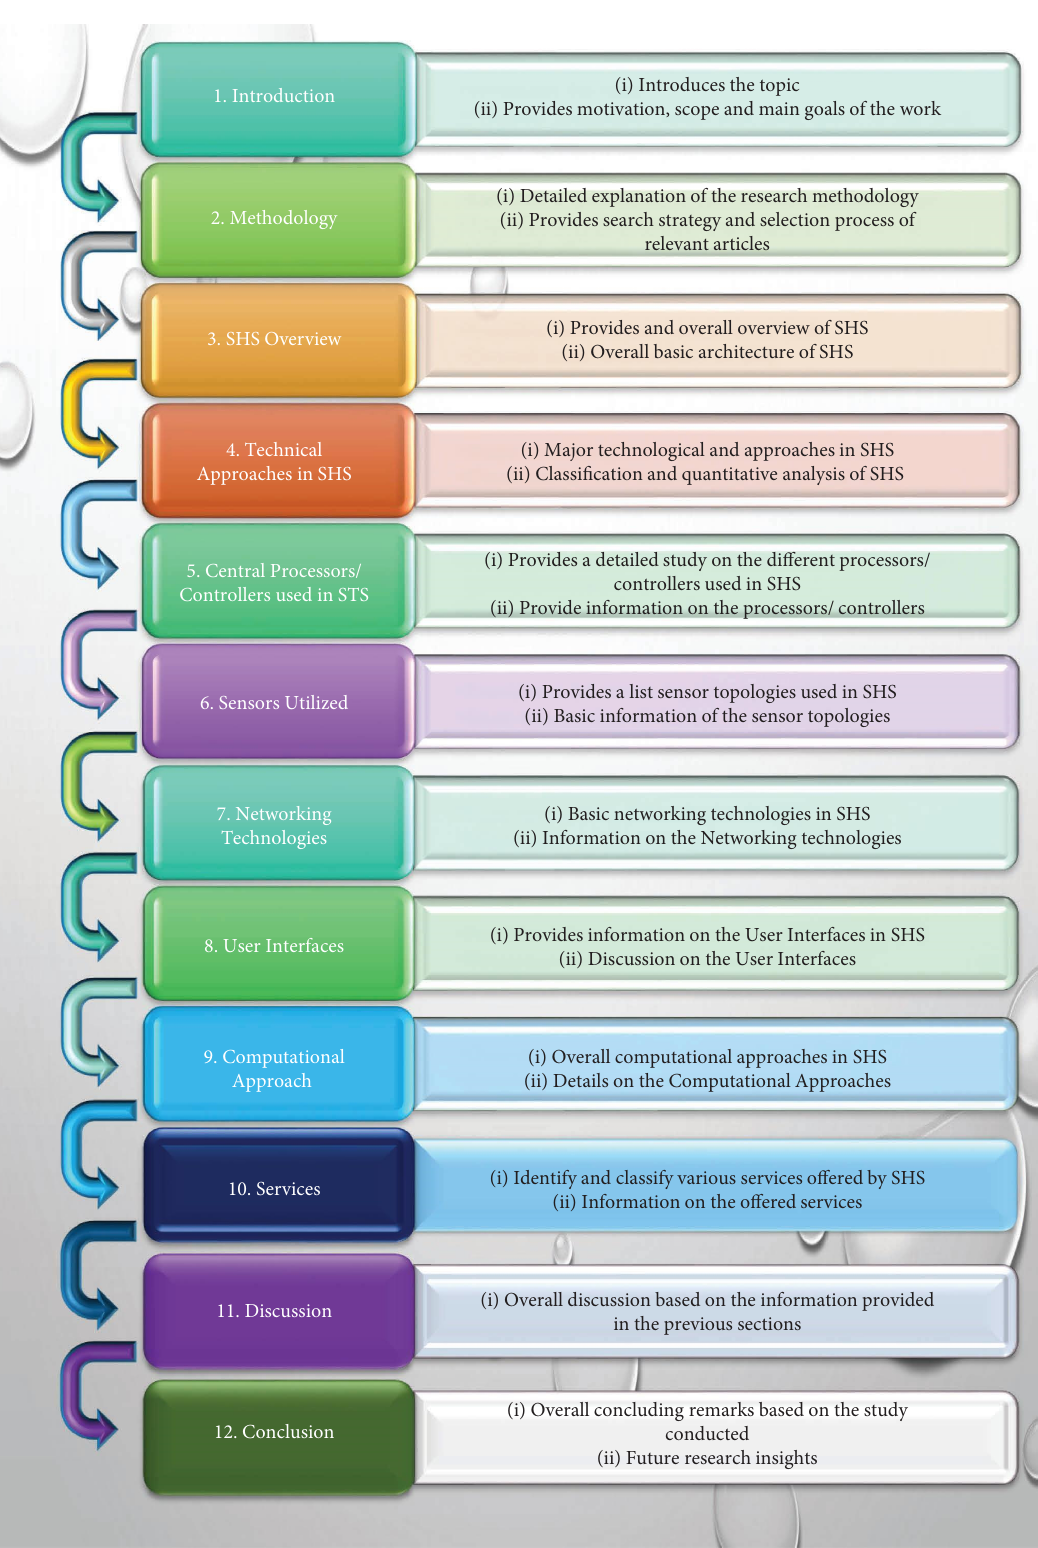
Figure 1: Structure of this